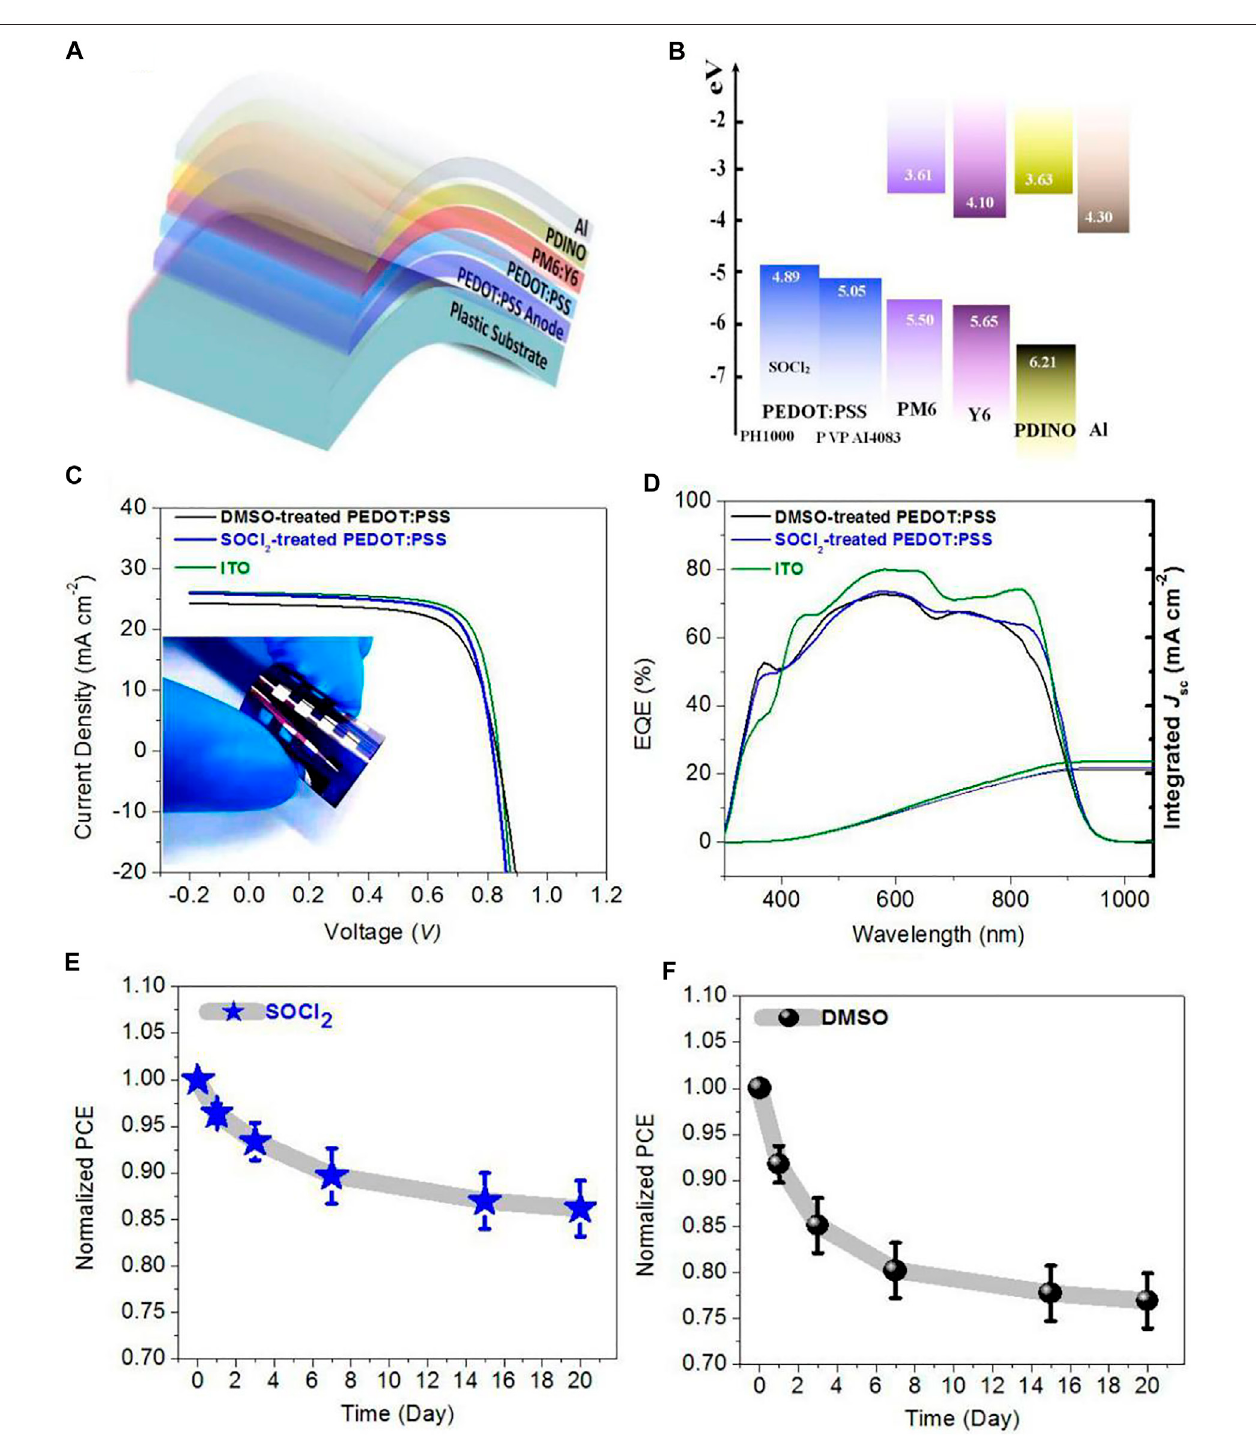
FIGURE 5 | (A) Schematic diagram of fl exible OSCs. (B) Energy levels of OSC components. (C) J − V characteristics of fl exible OSCs with SOCl 2 - and DMSO- treated PEDOT:PSS electrodes and control OSCs fabricated on ITO/glass substrates. (D) EQE spectra of these OSCs. (E,F) Decays of normalized PCEs of the fl exible OSCs with the PEDOT:PSS electrodes treated by SOCl 2 (E) and DMSO (F) , respectively.